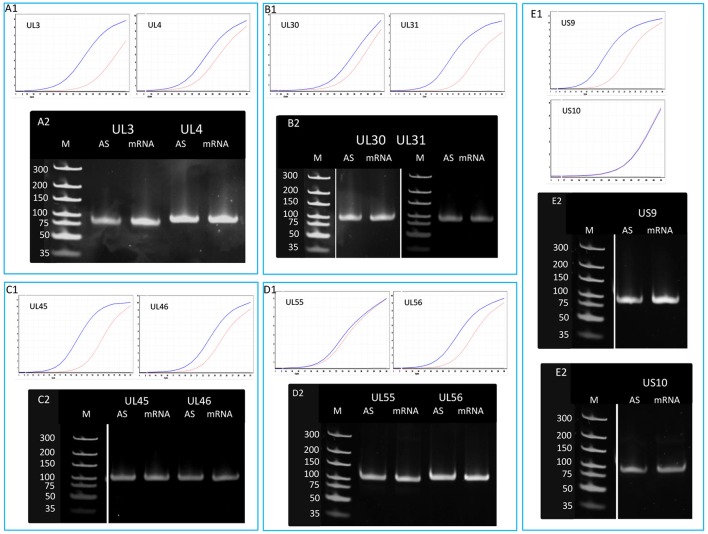
Detection of the antisense RNAs produced from the complementary DNA strands of 10 convergent HSV genes. A quantitative RT-PCR technique was used for the analysis of potential asRNAs derived from the transcriptional read-through between convergent genes. The amplification curves obtained by qRT-PCR are shown to demonstrate the specificity of the amplification. The curves of specific transcripts cross the threshold line within 18.3–22.5 cycles, while the curves of NO-RT controls remain flat. Panel (A1) shows the expression curves of the transcripts produced from plus and minus strands of the ul3 and ul4 convergent gene pair. Panel (A2) shows PCR products of the UL3 and UL4 transcripts and their antisense partners. Panel (B) shows the qRT-PCR amplification curves (B1) and the PCR products (B2) of UL30 and UL31 mRNAs and their asRNA partners. (C1) qRT-PCR curves of UL45 and UL46 mRNAs and the asRNAs produced from the complementary strands of these genes. (C2) PCR amplification products from the ul45-ul46 genomic region. (D1) Amplification curves of the UL55 transcript and its convergent partner UL56, as well as the antisense transcripts produced from the complementary DNA strands. (D2) Gel electrophoresis of the PCR products amplified from cDNAs UL55 and UL56 HSV mRNAs and their antisense partners. Panel (E) illustrates the qRT-PCR expression curves (E1) and the PCR products (E2) of US9-US10 mRNAs and their asRNAs. Gel samples were collected after saturation.